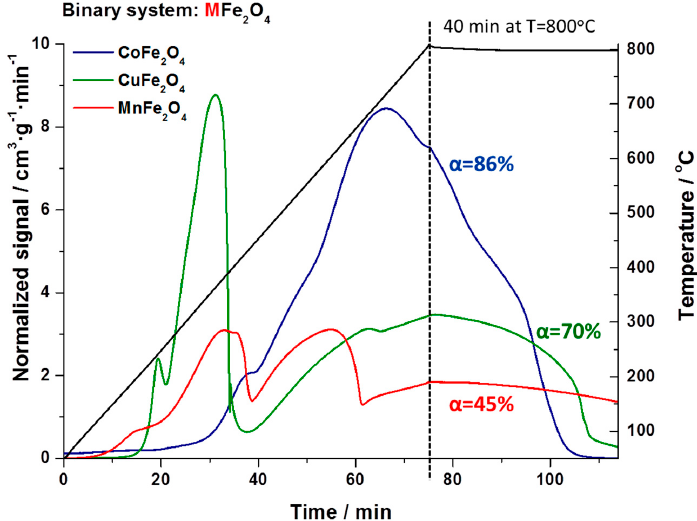
Figure 3. TPR profile of MFe 2 O 4 ferrospinels, where M = Cu, Co or Mn; α = degree of reduction (%).